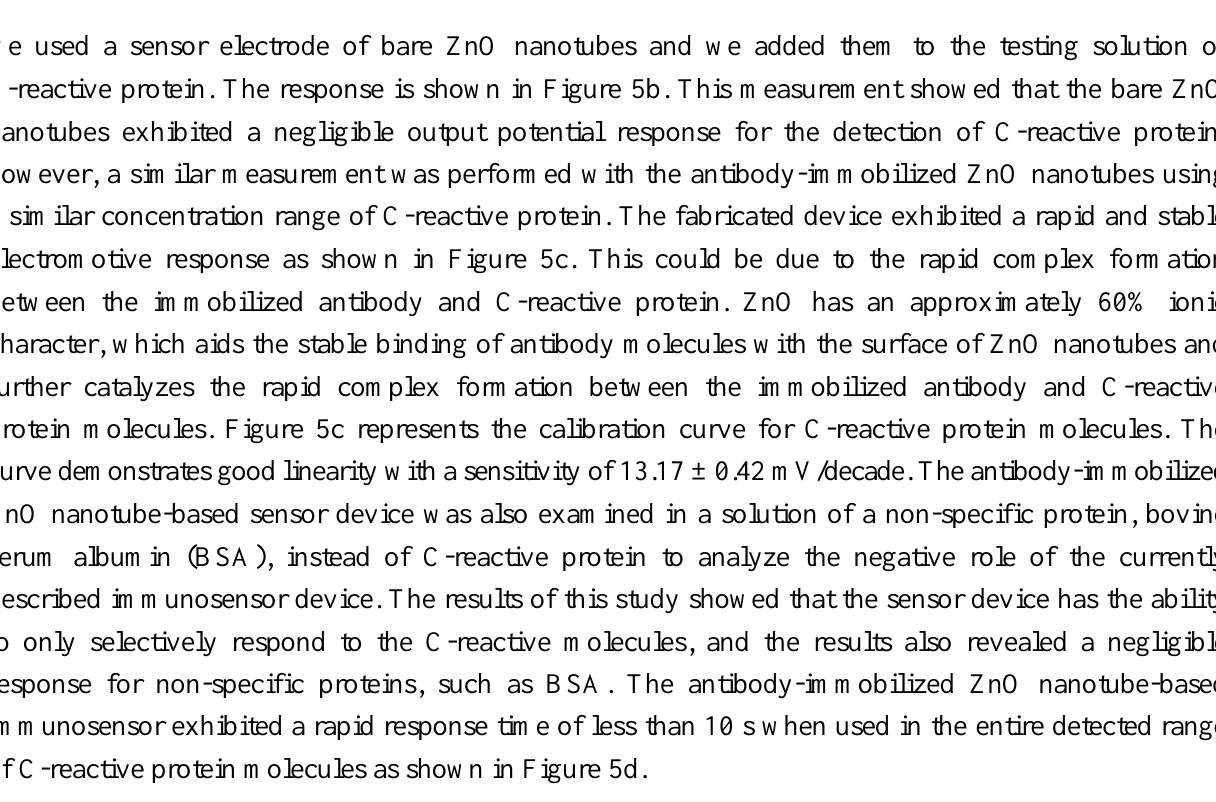
Figure 5. ( a ) SEM image of ZnO nanotubes; ( b ) calibration curve of bare ZnO nanotubes for CRP-antigen; ( c ) calibration curve of antibody-immobilized ZnO nanotubes for CRP-antigen; and ( d ) response time for all concentrations of the CRP-antigen biosensor